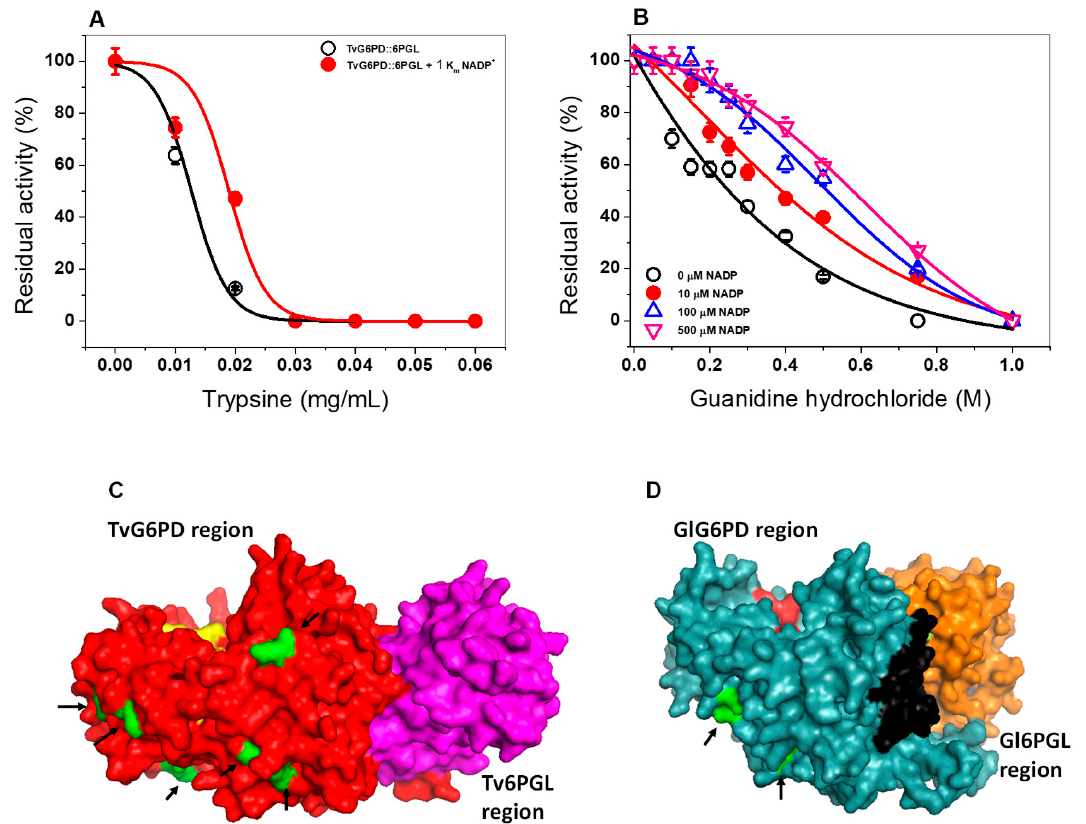
Figure 7. Evaluation of the stability of the TvG6PD::6PGL protein by trypsin digestion and guanidine hydrochloride (Gdn-HCl). ( A ) The trypsin enzymatic digestion of TvG6PD::6PGL in the presence of 1 K m of NADP + and different concentrations of trypsin. ( B ) Activity of the TvG6PD::6PGL protein in the presence of Gdn-HCl and three NADP + concentrations. For both assays, the protein was incubated for 2 h at 37 ◦ C, and the residual activity was measured. ( C ) A homology model of the full-length TvG6PD::6PGL protein and ( D ) G6PD::6PGL protein model from G. lamblia , showing the regions (in green) susceptible to digestion with trypsin (also indicated with arrows in both